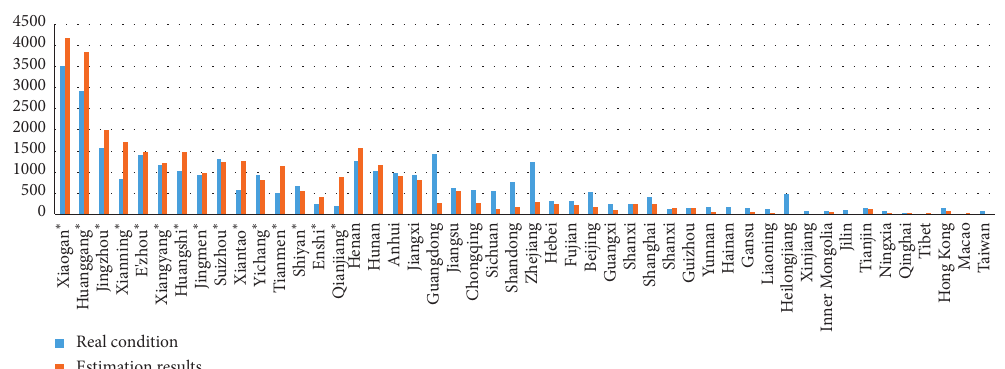
Figure 4: Comparison of the estimated number and the real number of incidence